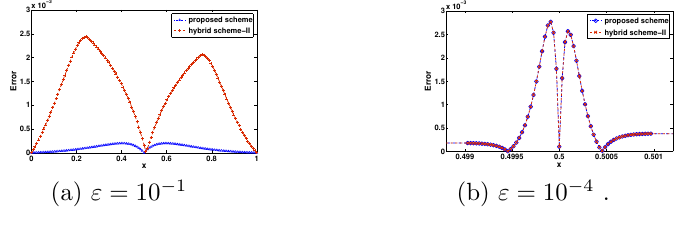
Figure 2. Comparison of error= (cid:12) (cid:12) u − U N (cid:12) (cid:12) obtained for ε = 10 − 1 , 10 − 4 and N = 128 on the mesh Ω N , for Example 1. In part (b) the zoomed view near x = 0 . 5 is presented.